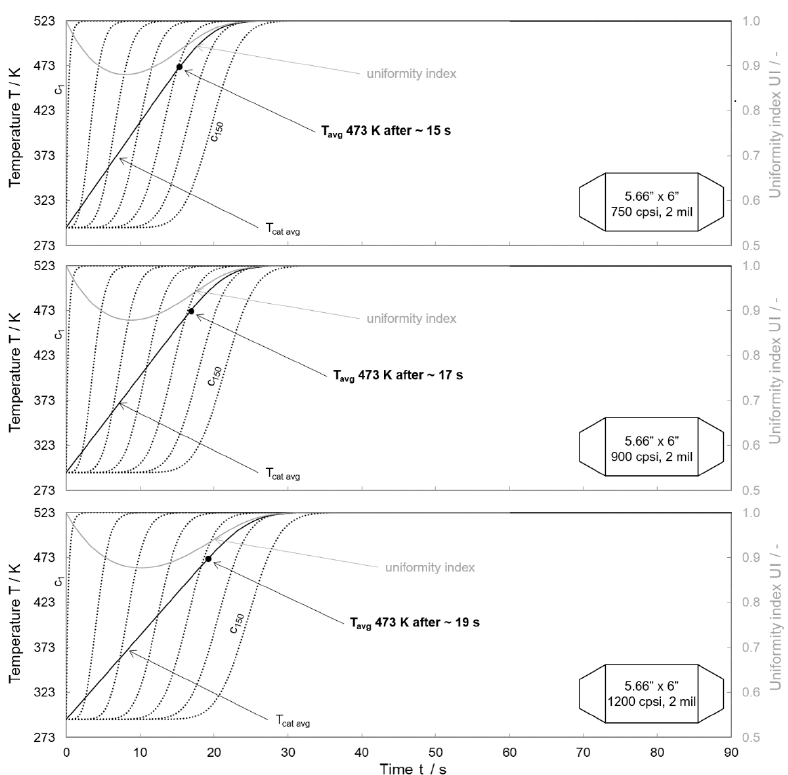
Figure 15. Steady state heat-up of monoliths with 2 mil at a flow rate of 100 kg/h and 523 K. Table 2 first summarizes the most significant parameters determining the heat-up duration — the mass of the monolith, an exemplary heat transfer coefficient for a gas tem- perature of 523 K and a flow rate of 100 kg/h, and the internal surface area 𝐴 𝑖𝑛𝑡 . Further- more, this table presents the time required to achieve an average temperature of 473 K ( 𝑇 𝑎𝑣𝑔 473 𝐾 ) over all solid cells and the uniformity index, which represents the homogeneity of temperature.